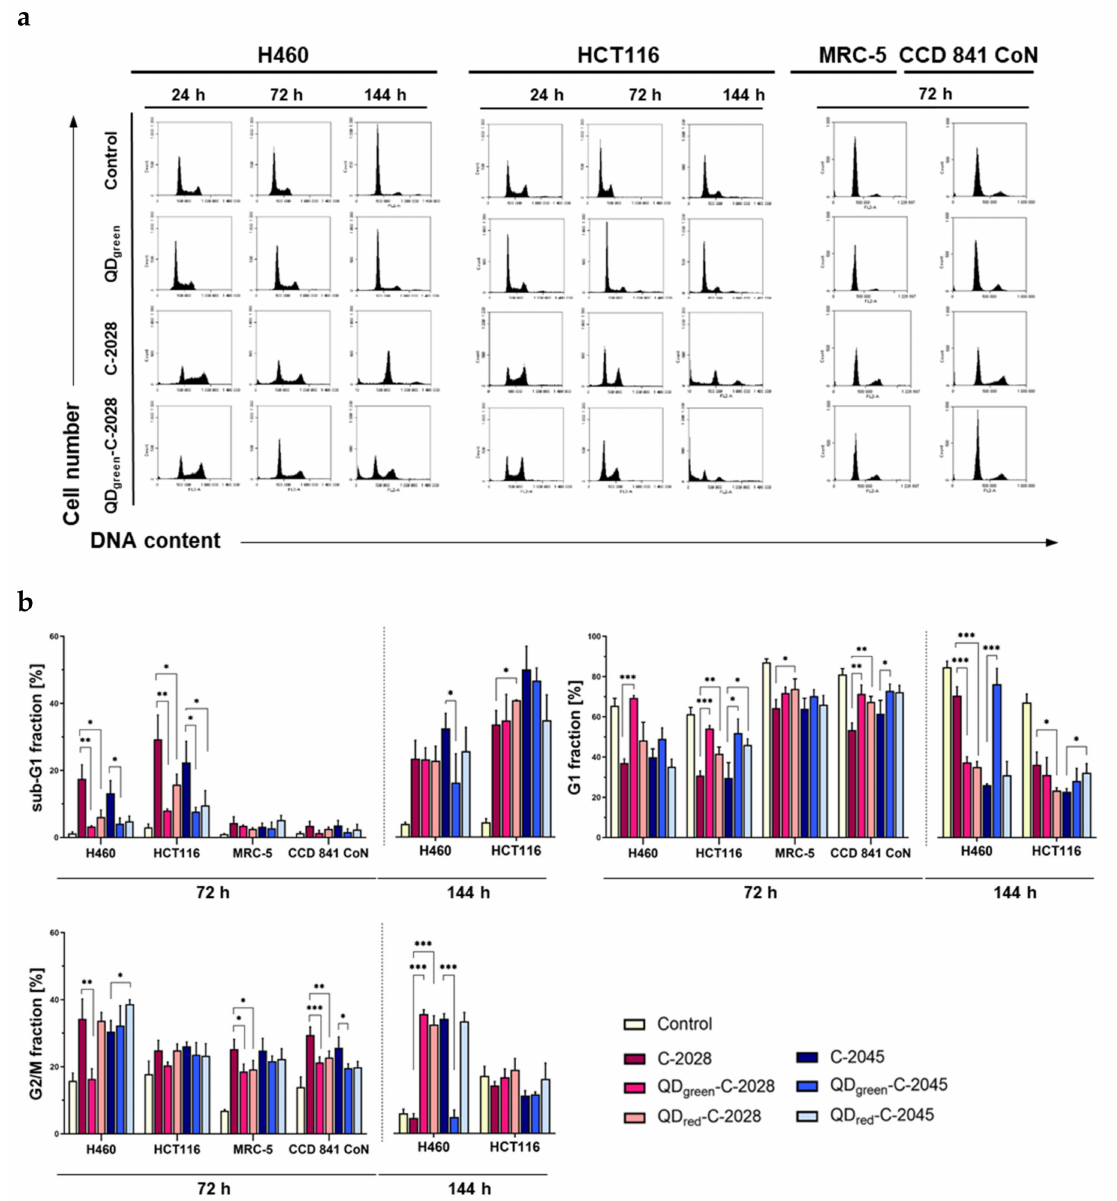
Figure 5. Cell cycle analysis of H460, HCT116, MRC-5, and CCD 841 CoN cells following treatment with QDs, UAs, and QD − UA hybrids for the time indicated. Cells were fixed in ethanol and stained with propidium iodide (PI), and their DNA content was measured by flow cytometry. ( a ) Representative plots of cells treated with selected QDs, UAs, and QD − UA hybrids. ( b ) Quantification of data shows the cell distributions in the sub-G1, G1, and G2/M phases of the cell cycle. Data represented the averages of three independent experiments. * p < 0.05, ** p < 0.01, *** p < 0.001 indicates statistically significant differences between fraction of cells incubated with UAs alone and QD − UA hybrids (Student’s t -test). In turn, the population of the G2/M phase gradually decreased following incubation with C-2028 alone and reached a similar level as in control cells (about 4.3%). Another bisacridine, the C-2045 derivative, also caused an increased number of cells in the sub-G1 phase (30% after 144 h), concomitantly with the reduction of cells in G1 phase (about